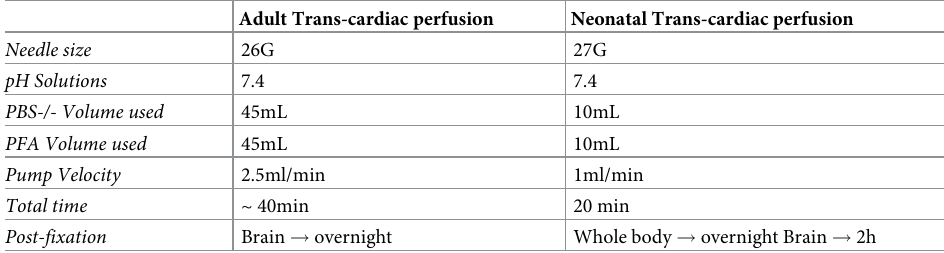
Table 2. Main differences between the adult and the neonatal trans-cardiac perfusion